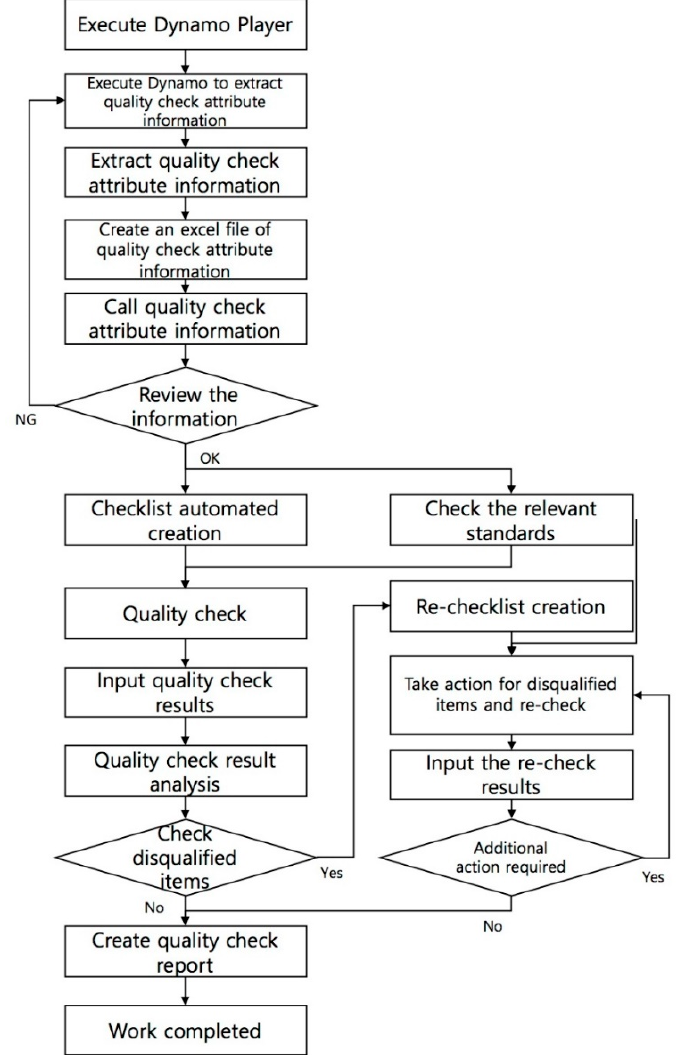
Figure 17. Process flowchart—temporary facilities quality inspection module.